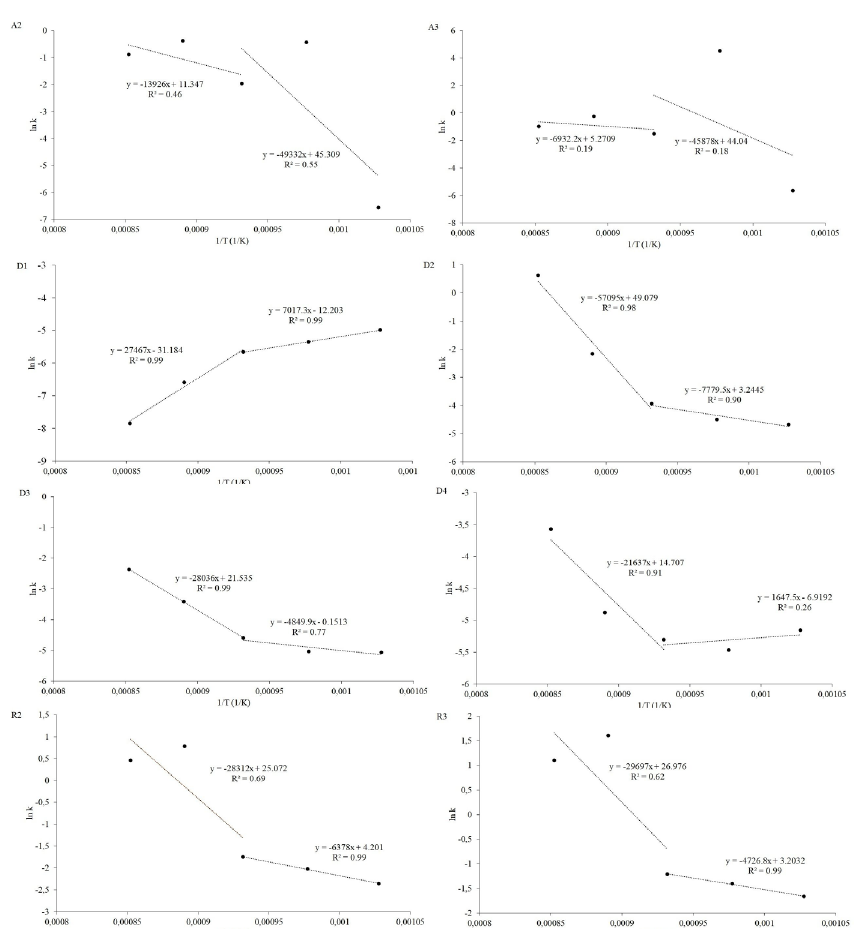
Figure 11. Arrhenius plots of the reduction of the iron-ore pellet containing lime sludge under CO